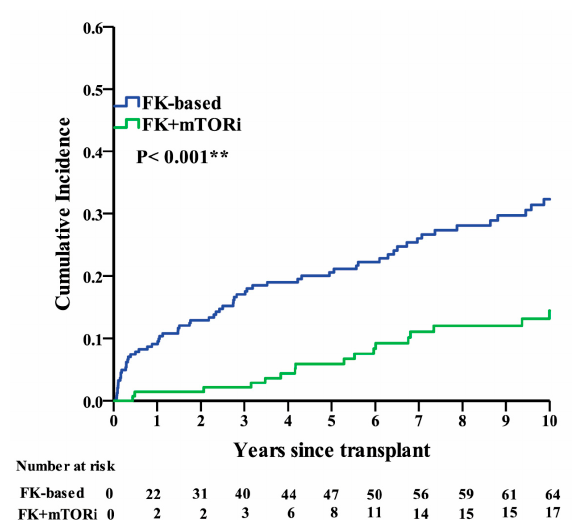
Figure 2. Kaplan–Meier analysis of the cumulative incidence of post-transplant diabetes mellitus